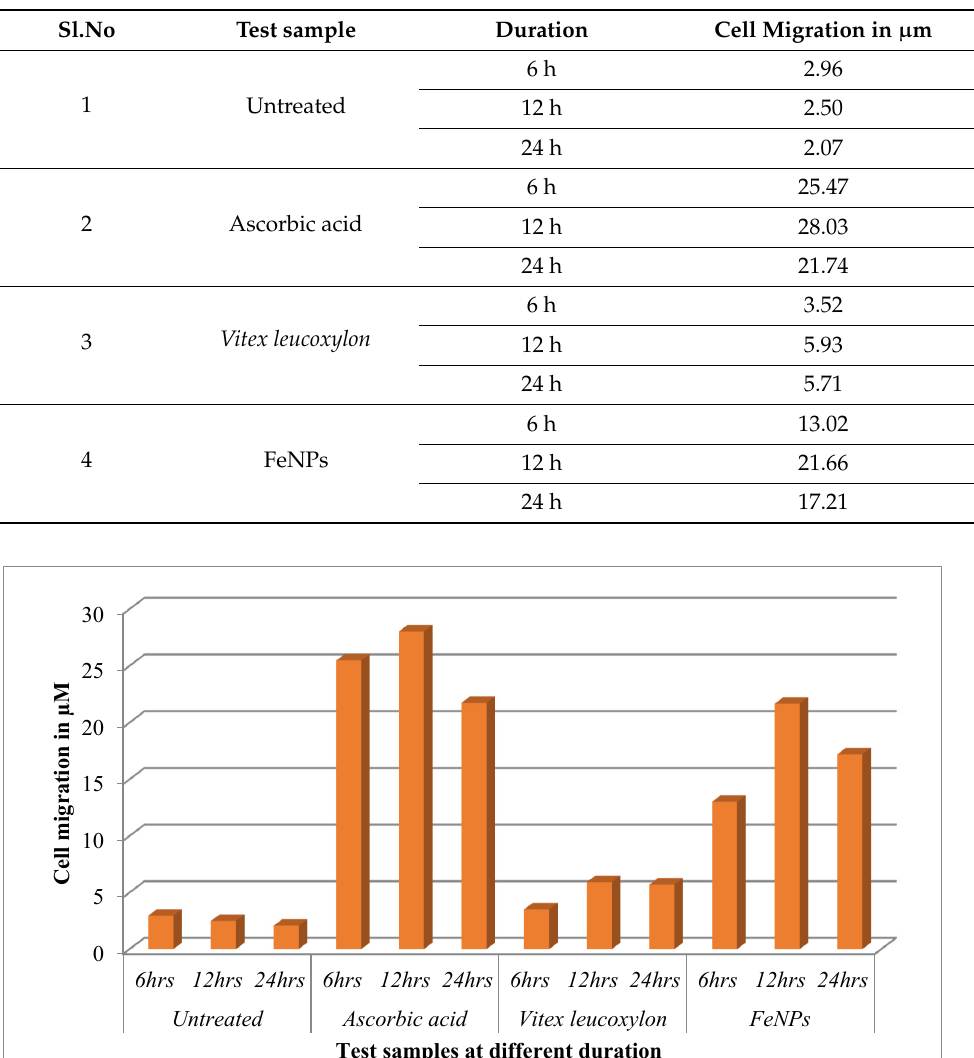
Table 9. Cell migration of different test samples at different duration.